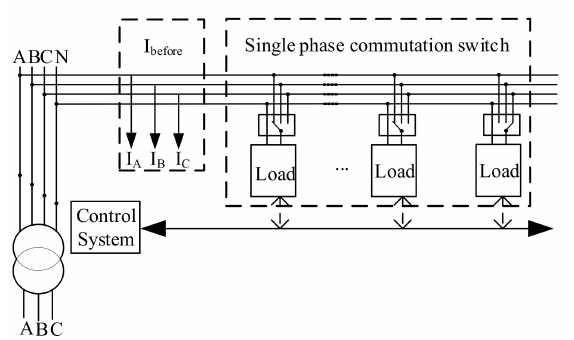
Figure 4. Low voltage load on-line automatic commutation